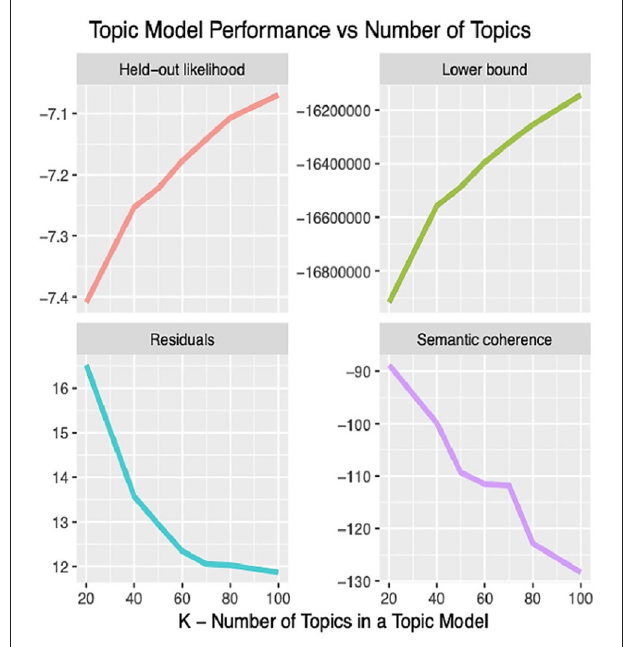
FIGURE 5 | Topic model performance vs. numbers of